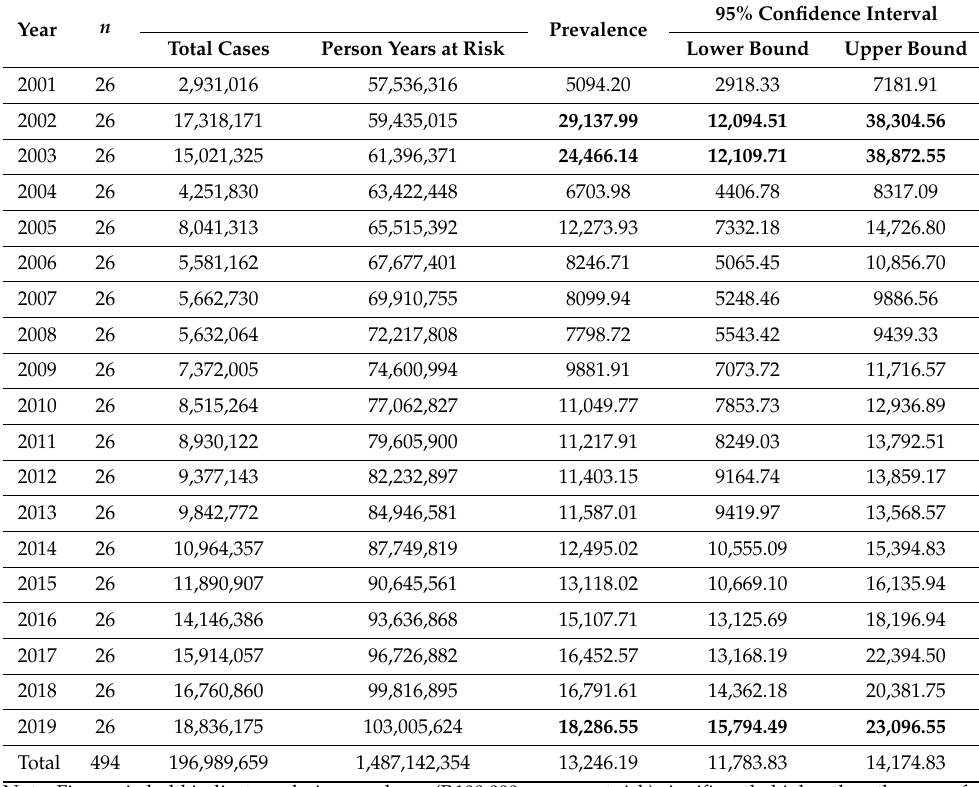
Table A1. Malaria prevalence rate (P.100.000 persons at risk) in DRC,